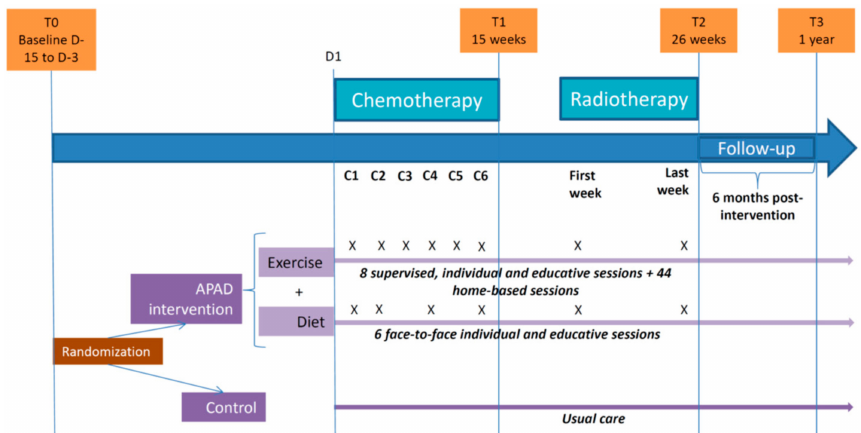
Figure 1. Flow diagram of the Adapted Physical Activity Diet 2 (APAD2) trial. C indicates chemotherapy cycle time points. X indicates intervention times in the associated randomization arm. Number of participating patients: T0 (Baseline): Control ( n = 180), Adapted Physical Activity Diet (APAD) ( n = 180). T2 (completed Chemotherapy and Radiotherapy sessions): Control ( n = 170), APAD ( n = 160). T3 (1